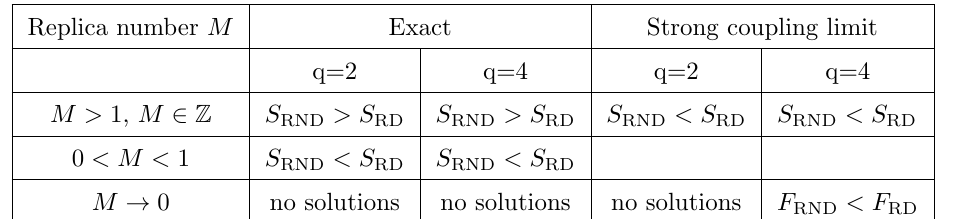
Table 2 . A summary of replica-nondiagonal solutions considered in the present work. S the on-shell action on the dominant nondiagonal solution (among obtained ones), F RND denotes the lowest regularized free energy on a nondiagonal